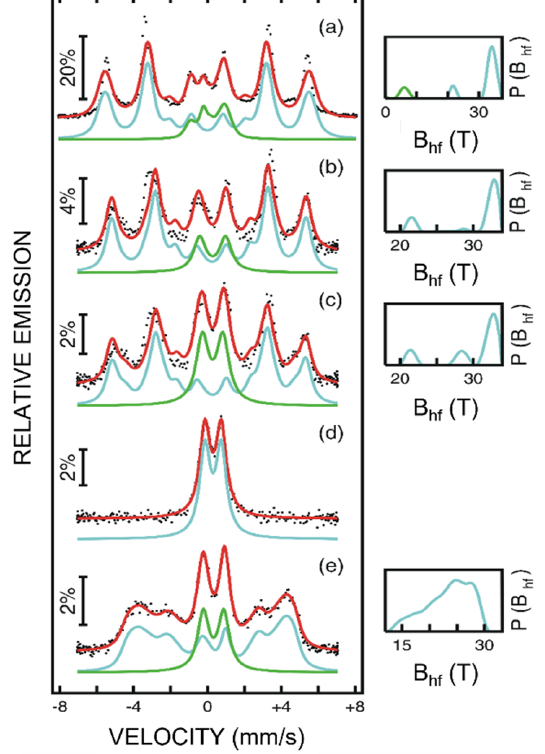
Figure 7. Room temperature Conversion Electron Mössbauer (CEM) spectra of ( a ) Au 20 Fe 80 , ( b ) Au 70 Fe 30 70, ( c ) Au 70 Fe 30 17, ( d ) Au 70 Fe 30 6, and ( e ) Au 80 Fe 20 70. On the right side of each spectrum, the corresponding distribution of hyperfine magnetic fields is presented.